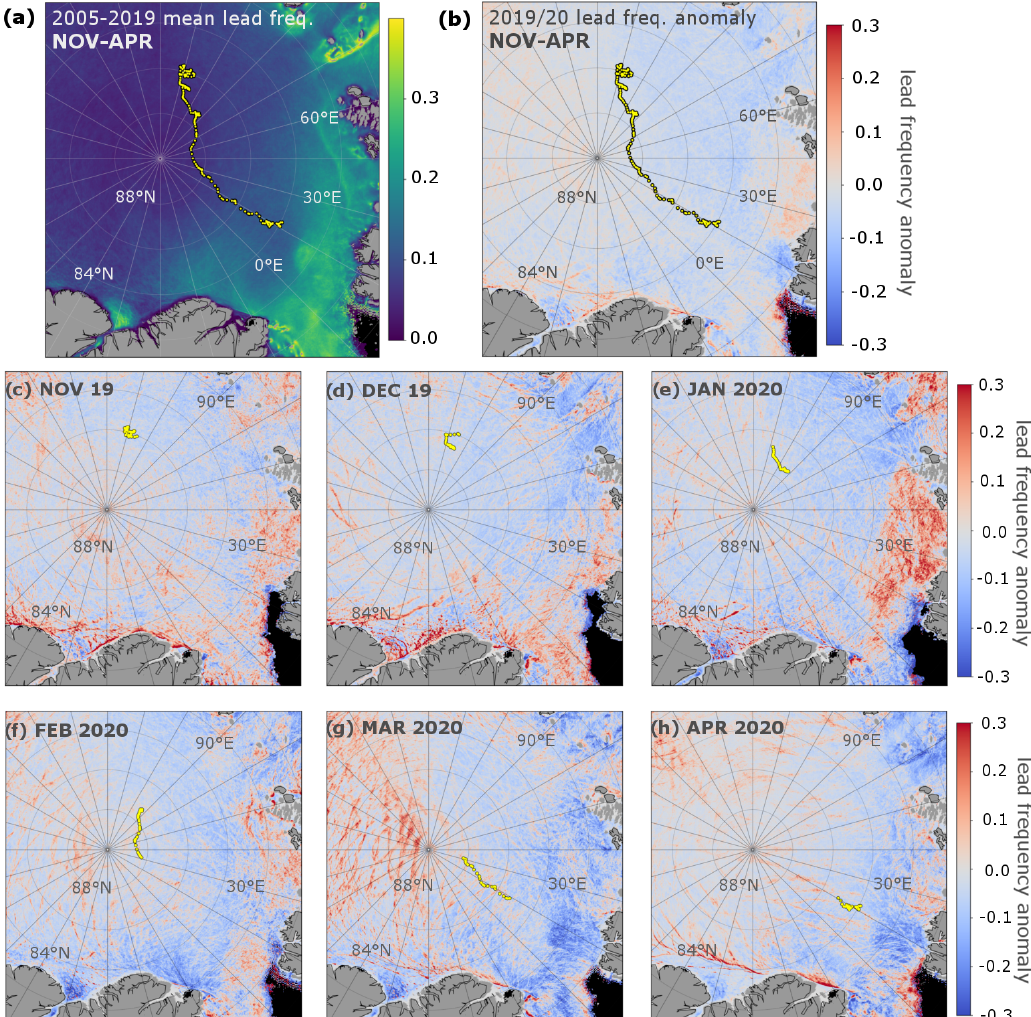
Figure 15. (a) Spatial distribution of the mean frequency of the occurrence of sea ice leads for the months of November to April for the winter seasons from 2005–2006 to 2018–2019 (reference period). MOSAiC drift of the CO is shown by yellow dots. (b) Lead frequency anomaly for the MOSAiC winter 2019–2020 with respect to the reference period. (c–h) Monthly lead frequency anomalies for the months of November to April in 2019–2020,